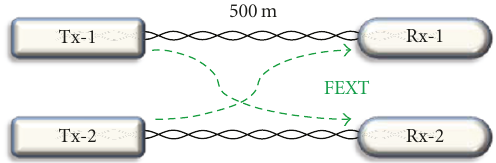
Figure 7: Access network scenario I with two FEXT channels of equal length.